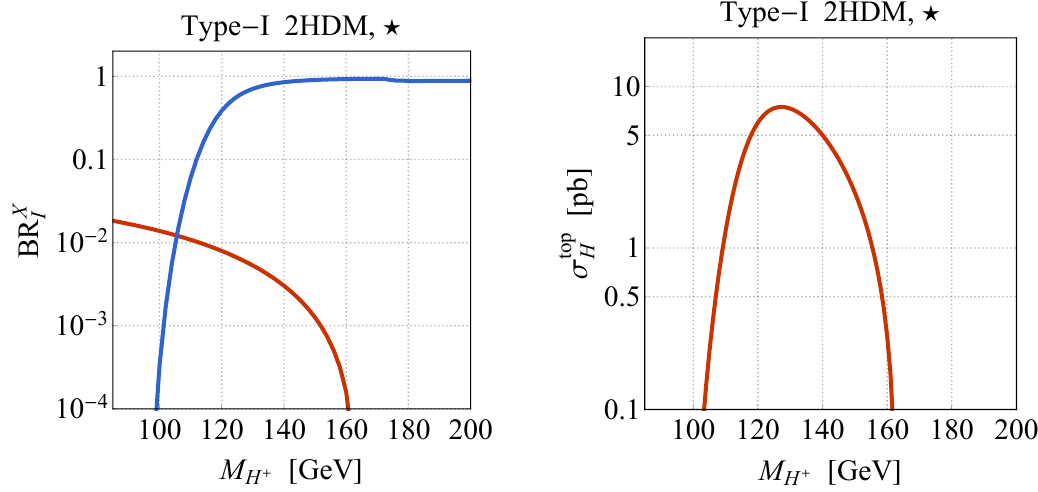
Figure 8 . Left: the t ! H + b (red) and H + ! W + H (blue) branching ratio as a function of M Right: the production cross section of H via top-pair and single-top production at multiplied by the branching ratios for benchmark scenario (3.2).